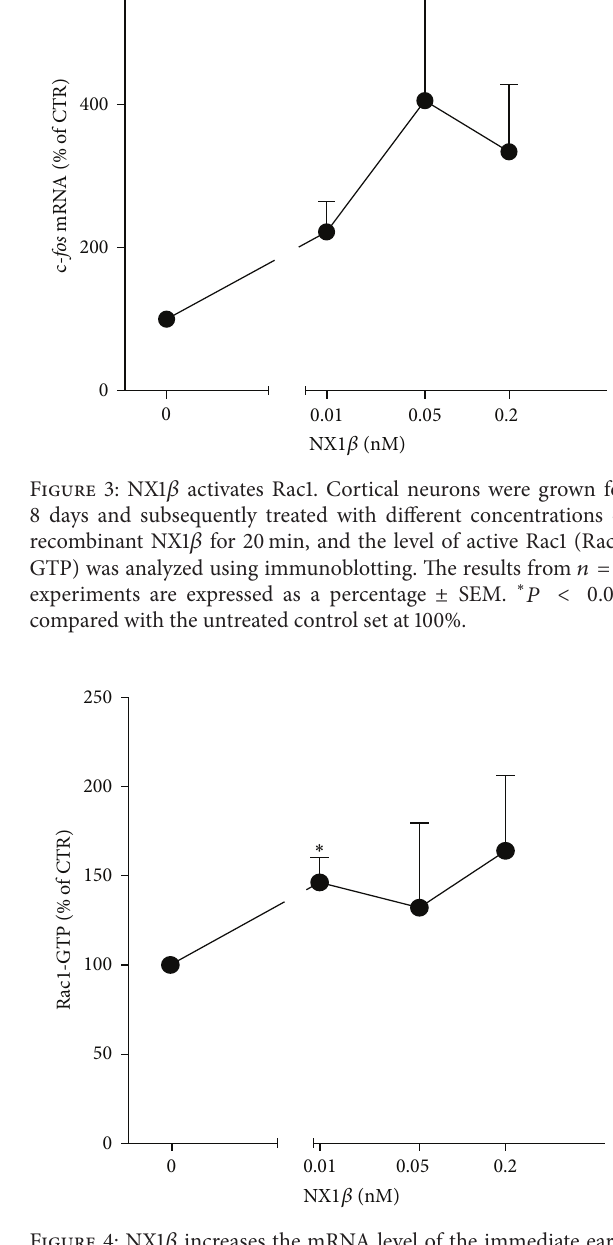
Figure 4: NX1 𝛽 increases the mRNA level of the immediate early gene c- fos . Cortical neurons were grown for 8 days and treated with different concentrations of recombinant NRXN1b for 2h. Total RNA was isolated, and mRNA levels were assessed using RT-PCR. The results from 𝑛 = 4 experiments are expressed as a percentage ± SEM. ∗ 𝑃 < 0.05 , compared with the untreated control set at 100%. Ser897 was significantly increased by 0.05 nM ecto-NX1 𝛽